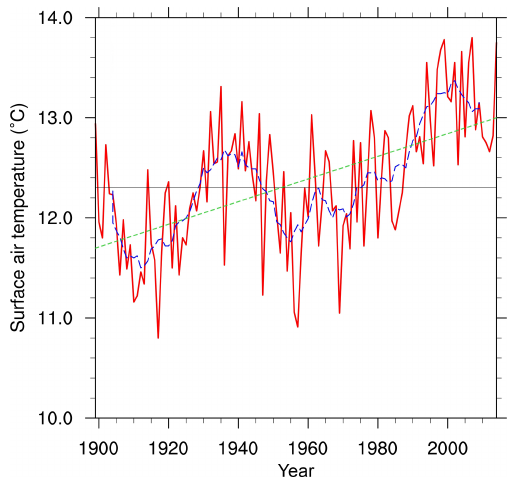
Figure 6. Construction of annual mean SAT ( ◦ C) in Qingdao for the period 1899–2014 (red solid line) and the 10-year running mean (long dashed line). The short dashed line represents the long-term linear trend. The thin black solid line shows the climate annual mean SAT relative to